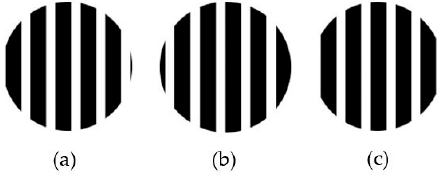
Figure 16. Captured contour scenarios. ( a ) Stripe starts at ON state and finishes at OFF state. ( b ) Stripe starts at OFF state. ( c ) Stripe starts at ON state and finishes at ON state.